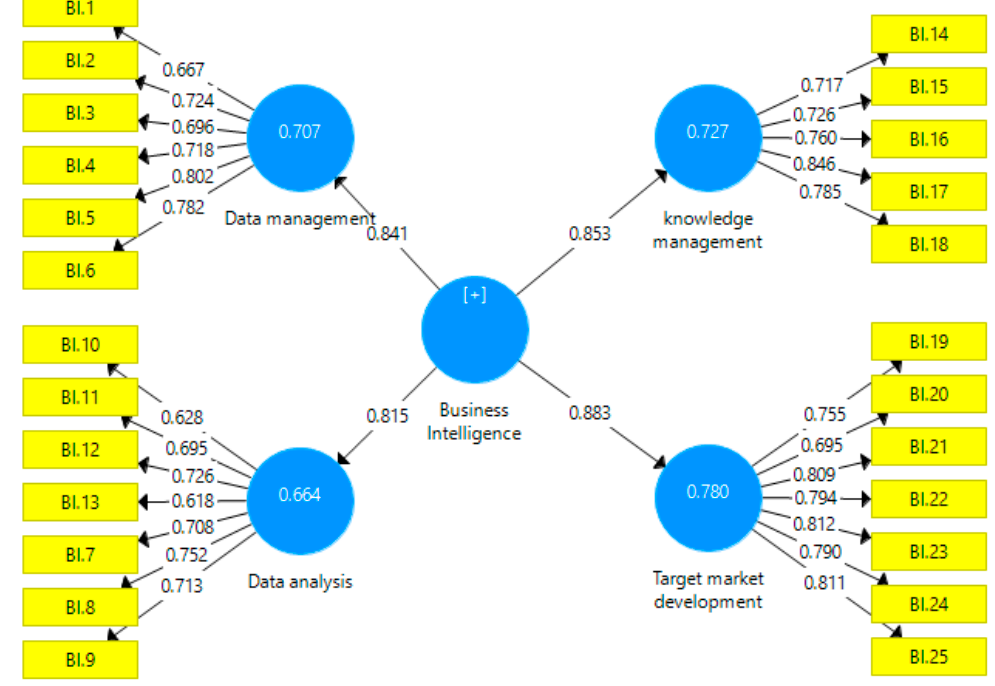
Figure 1. Coefficients of factor loadings for business intelligence